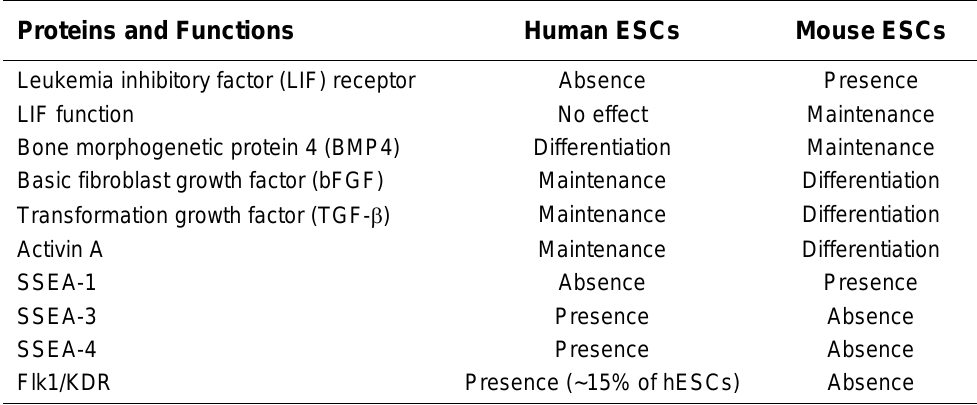
Differences between Undifferentiated Human and Mouse ESCs Proteins and Functions Human ESCs Mouse